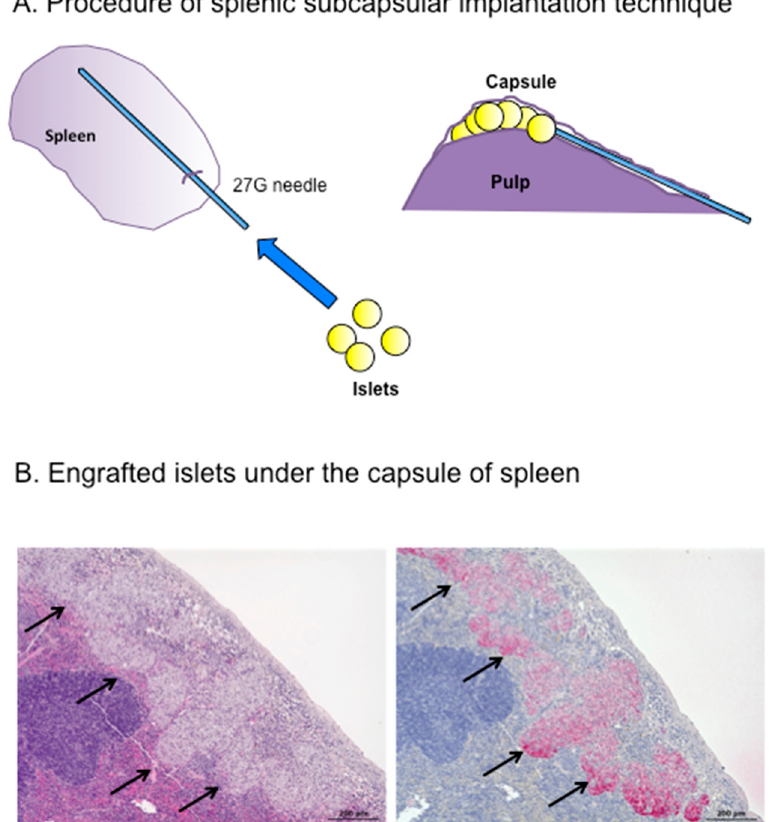
Figure 2. ( A ) Splenic subcapsular implantation technique; and ( B ) Engrafted islets (d arrows) under the spleen capsule 28 days after transplantation (( Left ) hematoxylin and eosin staining; and ( right ) immunostaining for insulin). Scale bar 200 μ m.